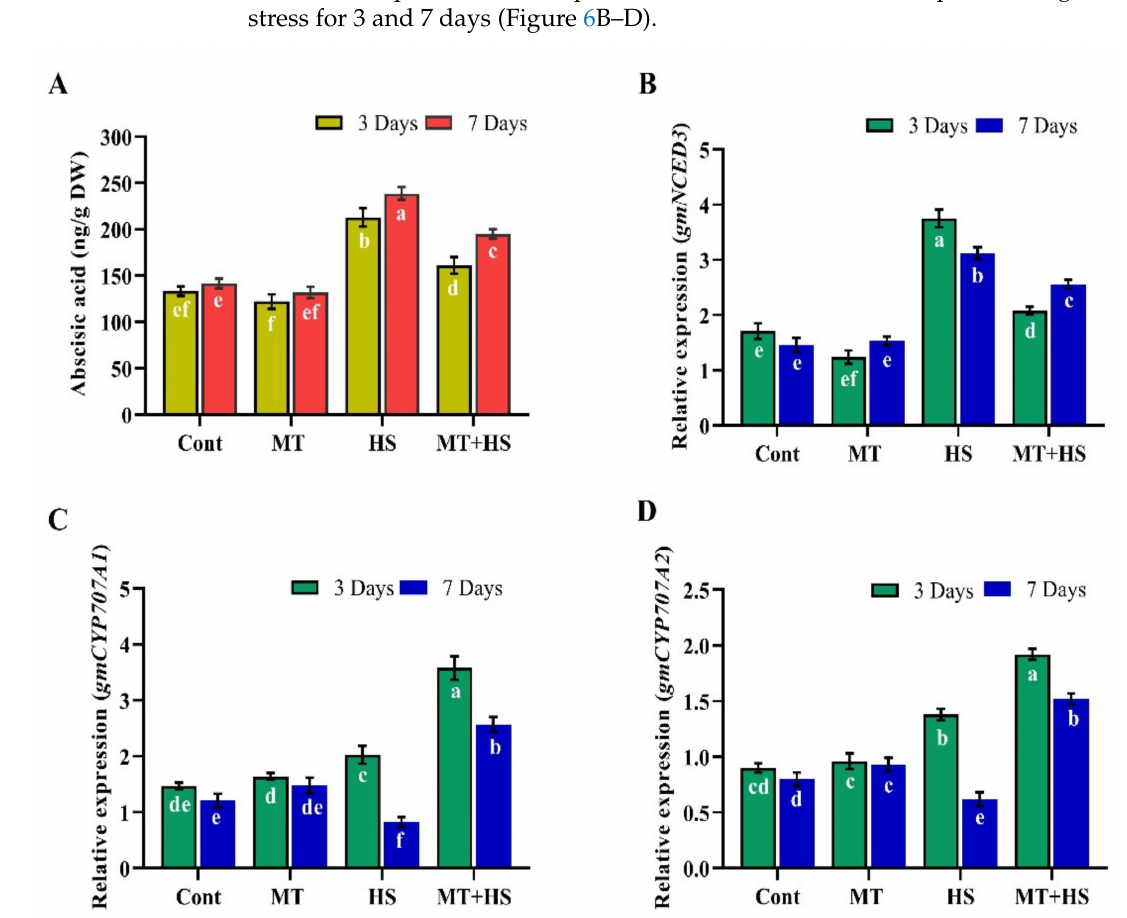
Figure 6. Effects of melatonin application with or without high temperature (42 ◦ C) on ( A ) abscisic acid content, ( B ) relative expression of ABA biosynthesis gene gmNCED3, ( C ) relative expression of ABA catabolic gene gmCYP707A1, and ( D ) gmCYP707A2 in soybean seedling after 3 and 7 days. Each data point is the mean of three replicates. Error bars represent the standard error of the mean. Bars with different letters are significantly different from each other by Duncan’s multiple range test at p ≤